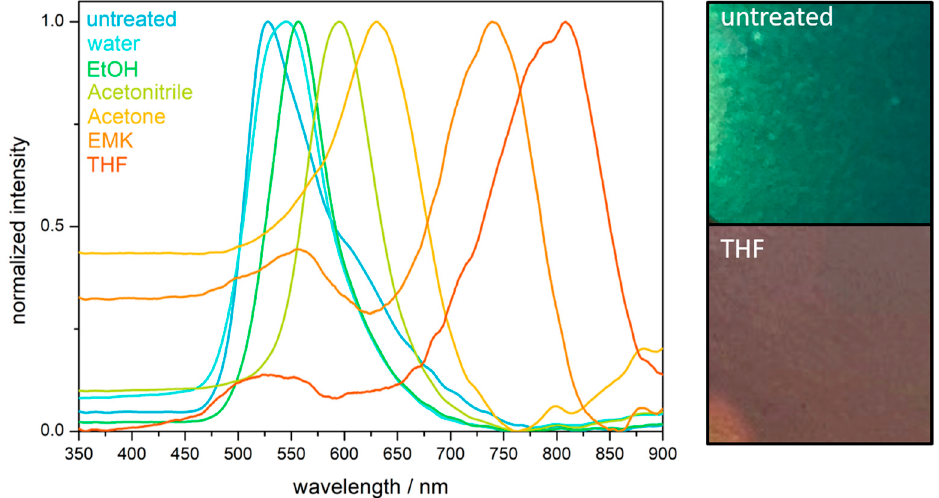
Figure 6. UV/Vis reflection spectra of a solvent-treated opal film based on PS@P(NFHMA- co -TFEA- co - n BuA) core/interlayer/shell particles ( left ) and exemplary photographs of the opal film prior to and after treatment with THF ( right ). Abbreviations: ethanol (EtOH), ethyl methyl-ketone (EMK), and tetrahydrofurane (THF).